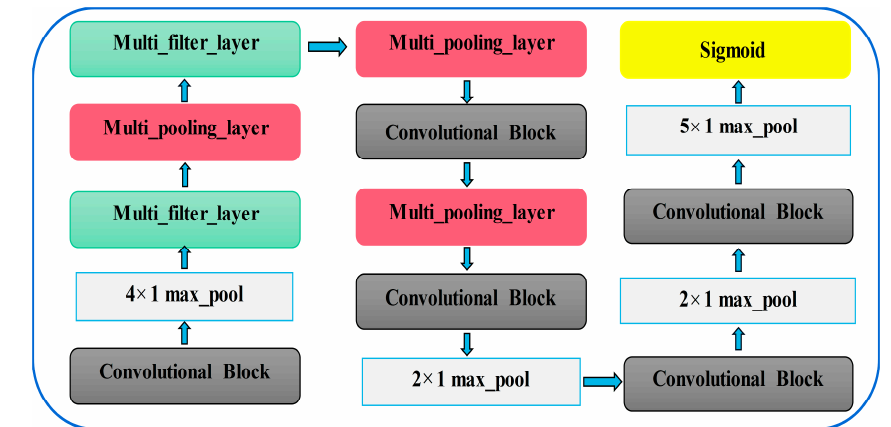
Figure 4. The bearing fault diagnosis method based on adaptive long sequence convolutional network